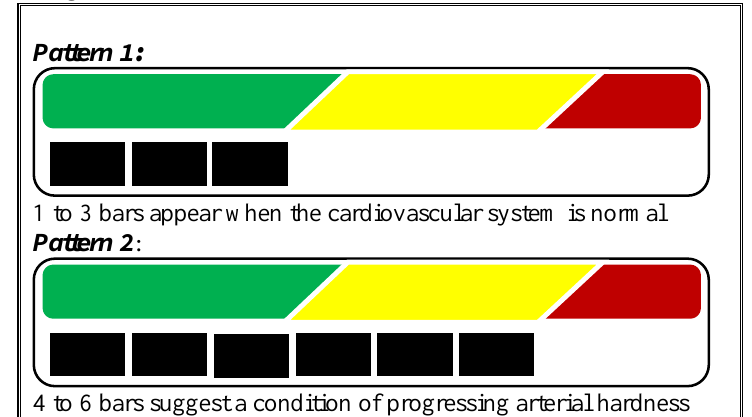
Figure 1: H-Value measurement result on the LCD Display of ASI measuring